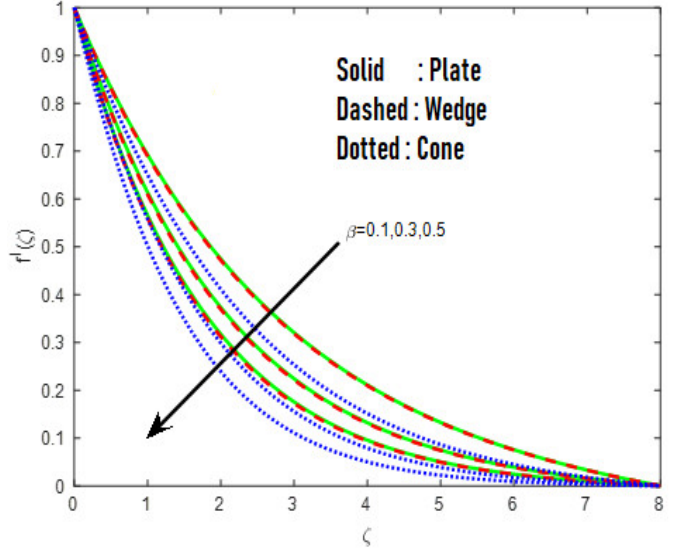
Figure 2.  vs.   ' f  . Figure 2. β vs. f (cid:48) ( ζ )